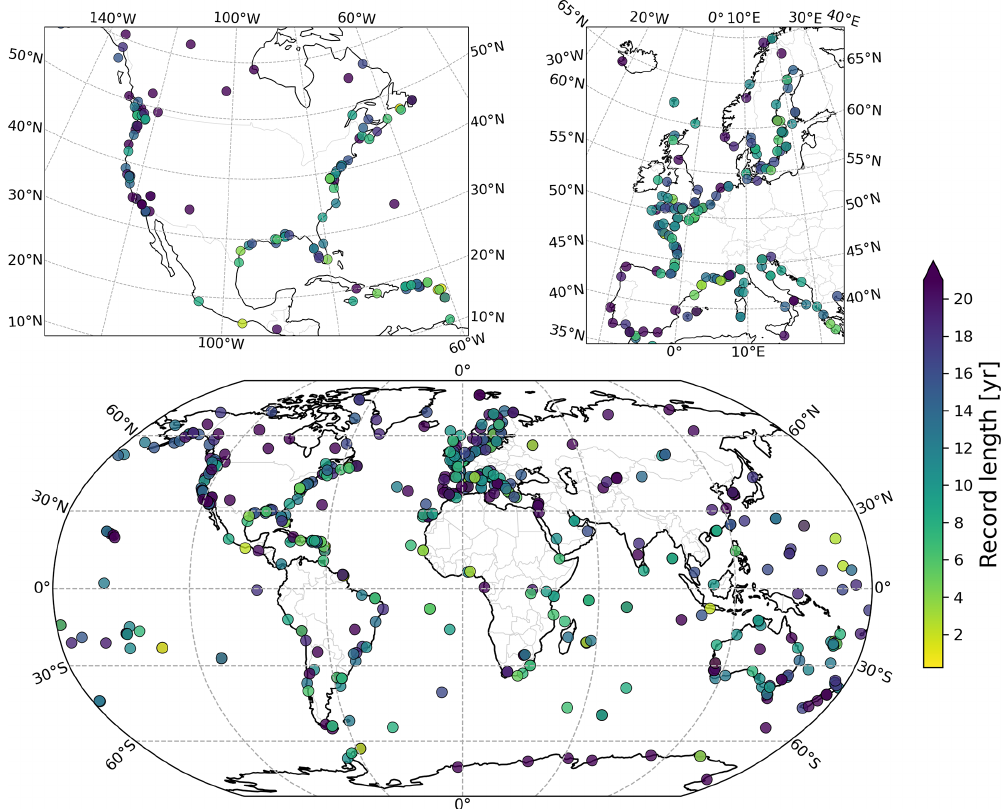
Figure 1. Spatial distribution of the 601 GNSS stations in ULR-repro3 and the record length (colour bar), which has a median of 13.1 years, spanning the 2000.0–2021.0 (in decimal years)